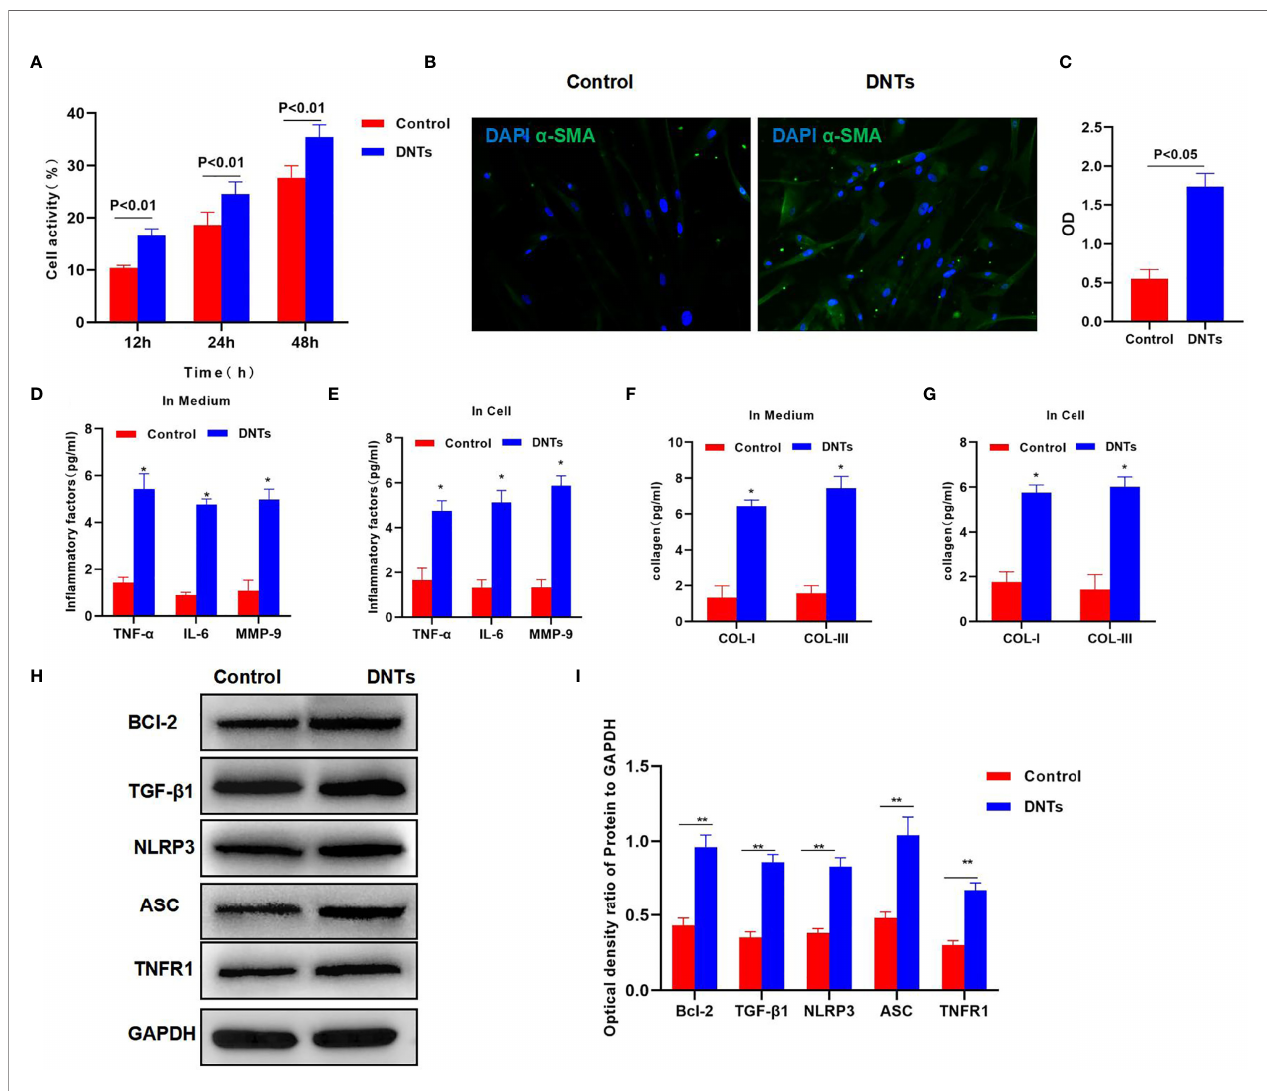
FIGURE 2 | Effect of DNTs on HSC activation and the mechanism. (A) DNTs promoted HSC proliferation. The cell viability of DNT group was signi fi cantly higher than that of control group. p < 0.01 between groups. (B, C) The fl uorescence intensity of HSC activation marker a -SMA in DNT group was markedly higher than that in control group. p < 0.01 between groups. (D, E) The expression levels of secreted in fl ammatory factors in cells and the culture medium. The intracellular and secreted in fl ammatory factor levels in DNT group were markedly higher than those in control group. DNTs promoted the expression of intracellular in fl ammatory factors. *p < 0.05 compared with control group. (F, G) DNTs promoted collagen expression in HSCs. The expression levels of intracellular and secreted COL-I and COL-III markedly increased. *p < 0.05 compared with control group. (H, I) DNTs promoted Bcl-2 protein expression, activated TNFR1 and NLRP3, and evidently upregulated protein levels. **p < 0.01 between groups. DNTs, double-negative T cells; HSC, hepatic stellate